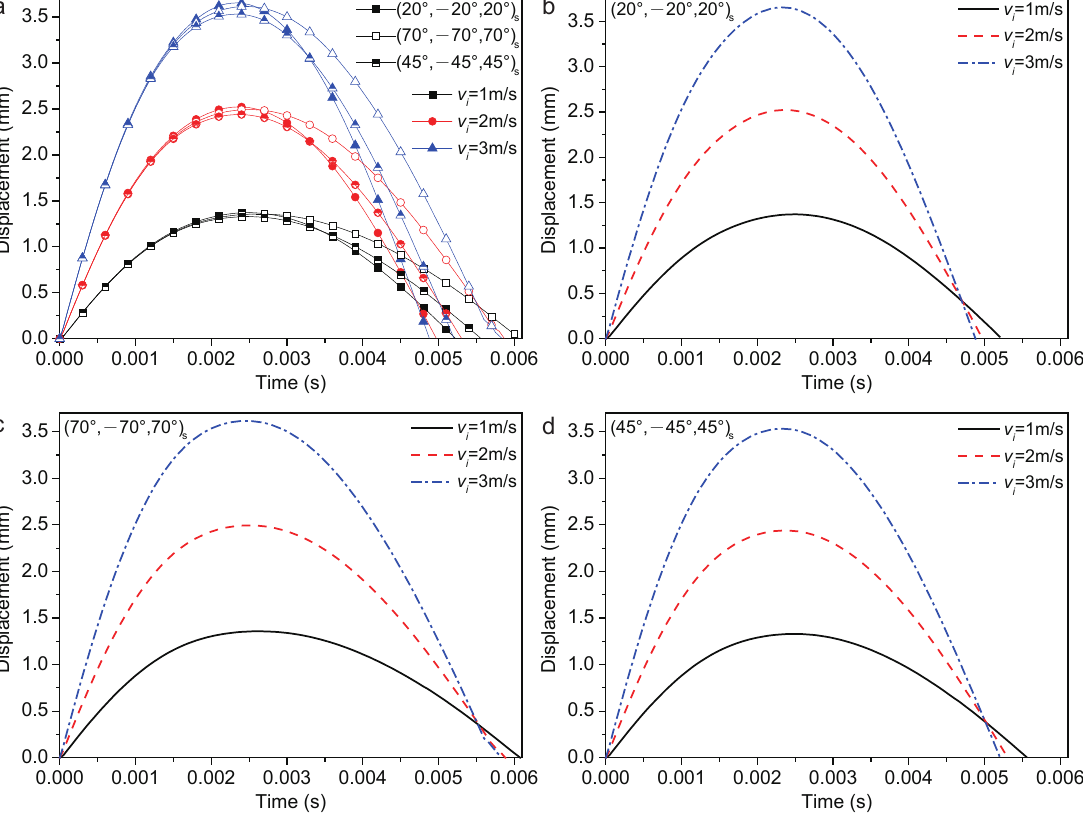
Figure 10. Plate center displacement response of the sandwich structure with various impact veloci- ties: ( a ) FG-O, UD and FG-V face sheets plate; ( b ) (20/ − 20/20)s plate; ( c ) (70/ − 70/70)s plate; and ( d ) (45/ − 45/45)s